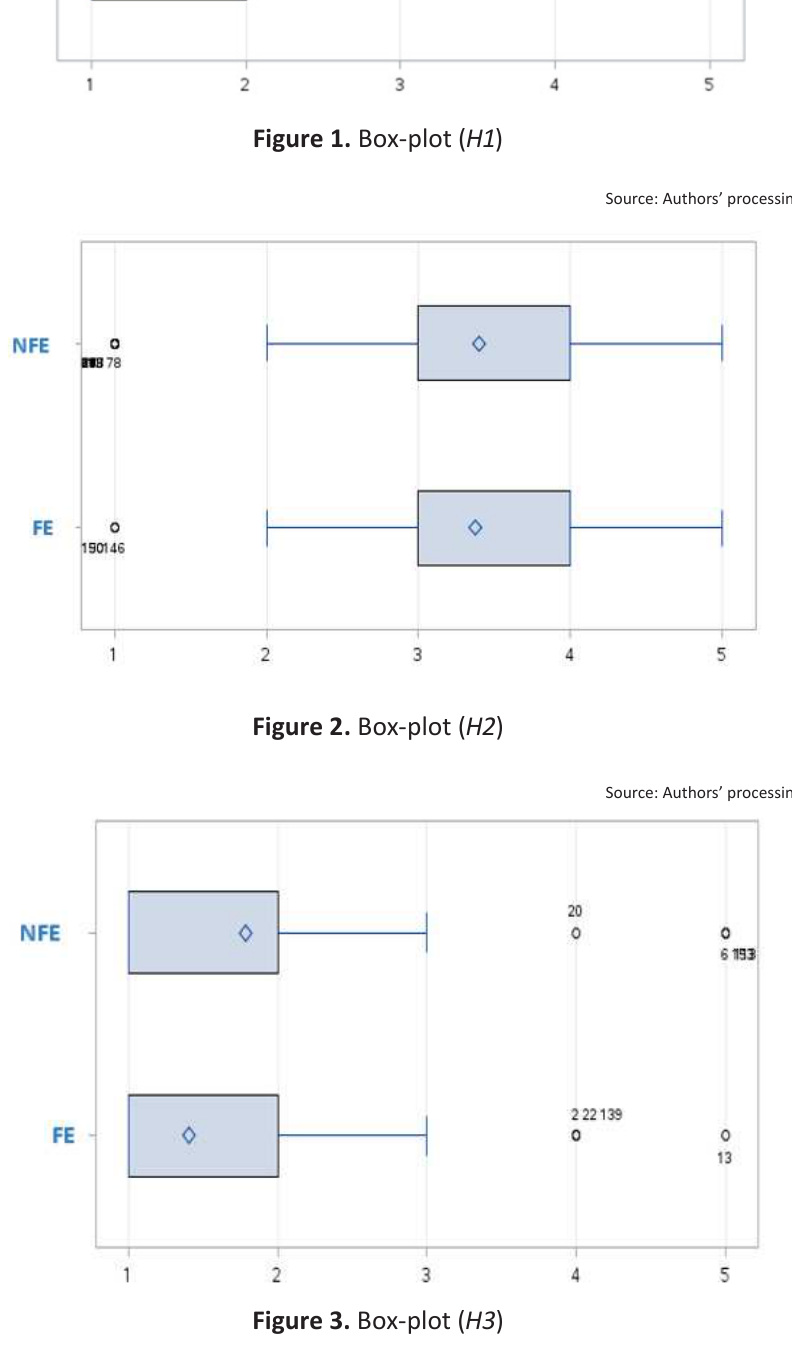
Figure 3. Box-plot ( H3